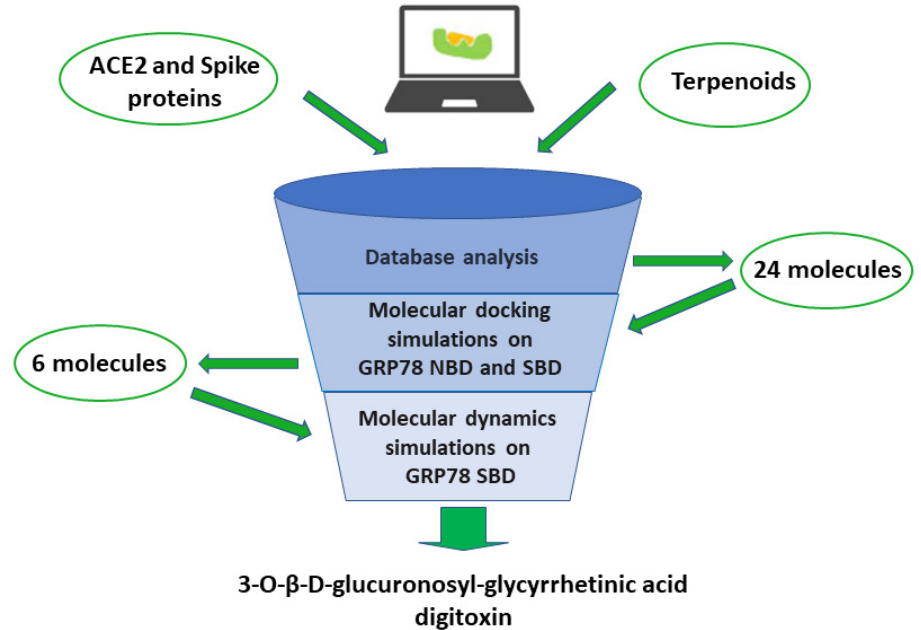
Figure 17. Starting with the examination of scientific literature, molecular docking and molecular dynamics simulations have allowed the identification of two terpenoids (digitoxin and 3-O- β -D- glucuronosyl-glycyrrhetinic acid) as potential ligands of GRP78